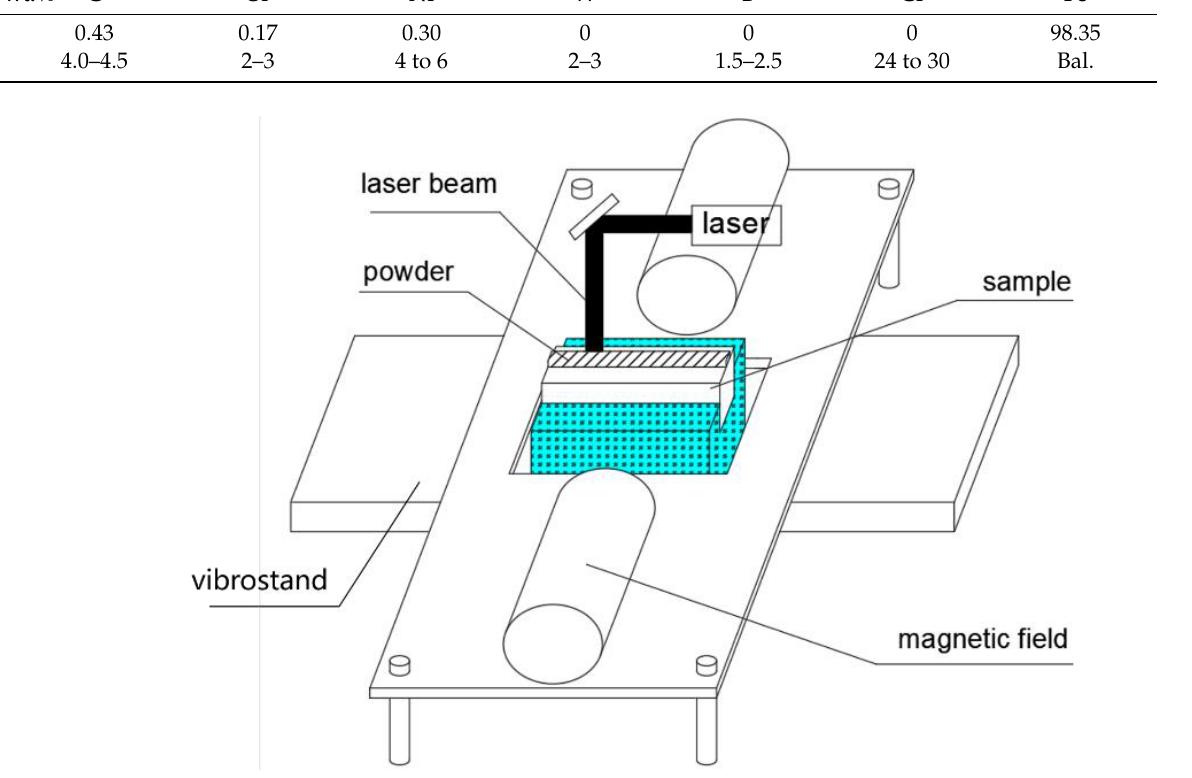
Figure 1. Overall structure of coupled field-assisted laser cladding device. Table 2. Comparison table of experimental schemes.